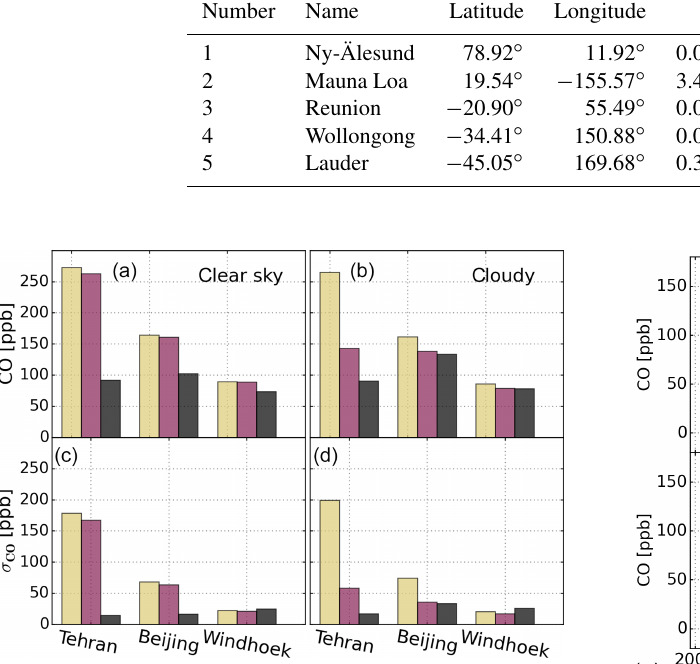
Figure 7. Mean CO column mixing ratio (a, b) and stan- dard deviation (c, d) of the time series shown in Figs. 5 and 6, SCIAMACHY (black), MOZAIC/IAGOS (yellow) and MOZAIC/IAGOS with SCIAMACHY column averaging kernels applied (pink). (a, c) Clear-sky SCIAMACHY retrievals and (b, d) SCIAMACHY retrieval for optically thick high cloud con- ditions.